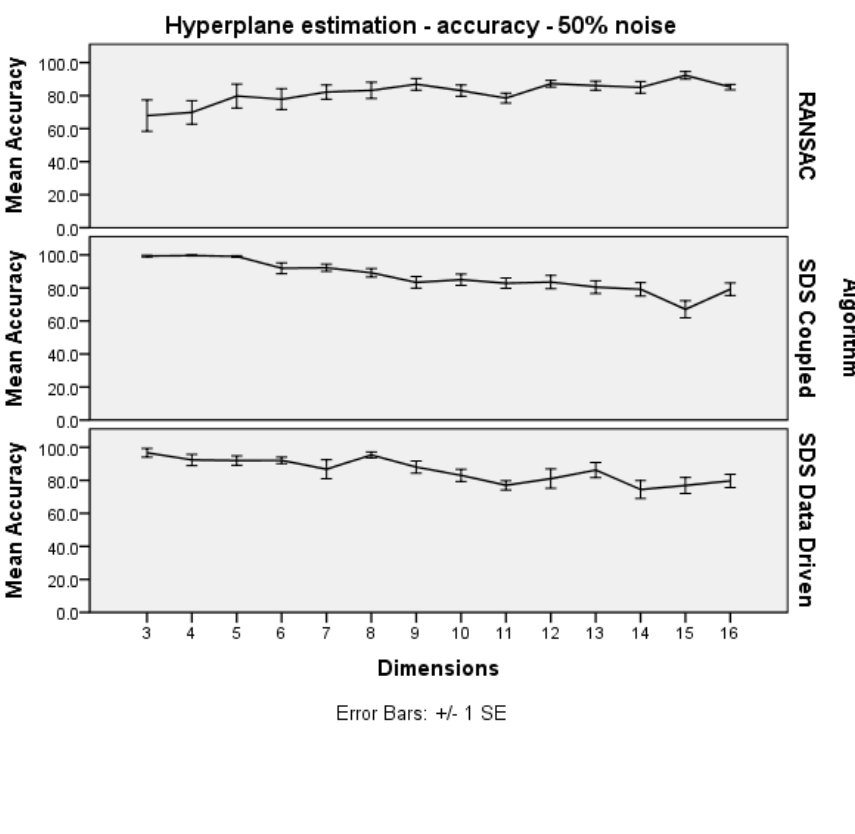
Figure 4. Hyperplane estimation dimensions trials: